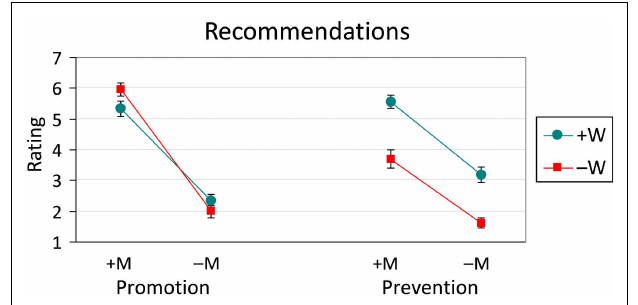
FIGURE 3 | Product recommendation ratings (with standard error bars) to promotion- and prevention-focused targets across Message (M) × Word (W) conditions. M andW conditions were either Positive ( + ) or Negative ( −